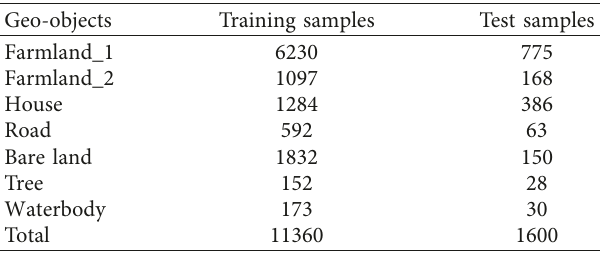
Figure 7: The peak value change of curves of four subset textures: (a) house radial curve, (b) house angular curve, (c) farmland_1 radial curve, (d) farmland_1 angular curve, (e) farmland_2 radial curve, (f) farmland_2 angular curve, and (g) mixed ground objects angular curve. Table 1: Number of samples for different